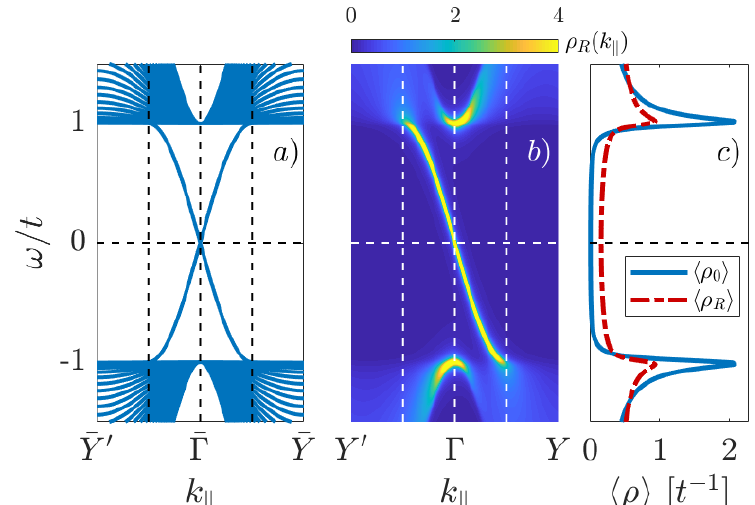
= 40 sites. The sites